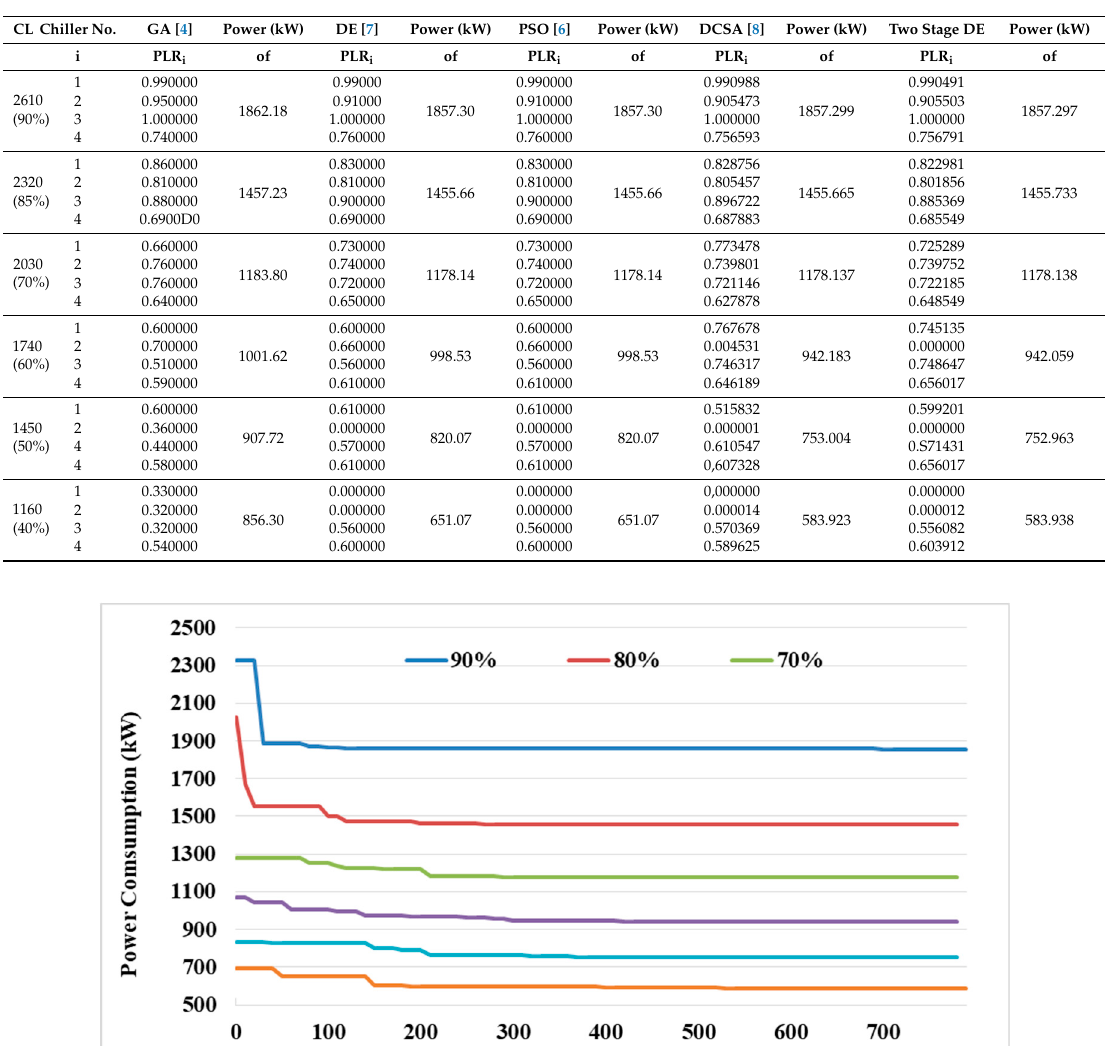
Table 6. Case study 2: comparison with the methods proposed by other studies. CL Chiller No.